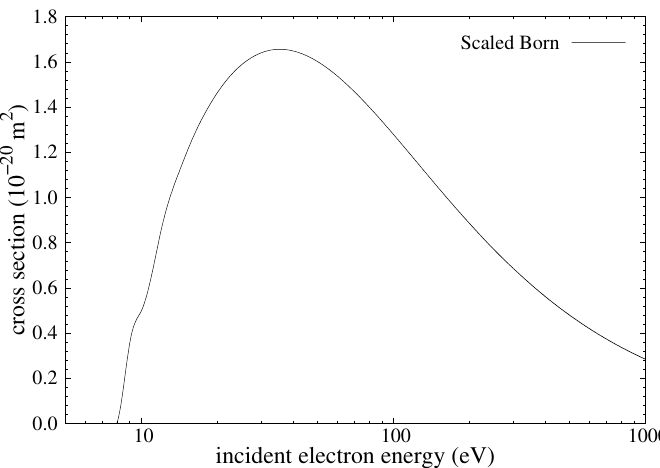
Figure 21. The scaled Born EA cross section for the 5 s 2 5 p 2 3 P 0 ground state is due to Kim and Stone [16].